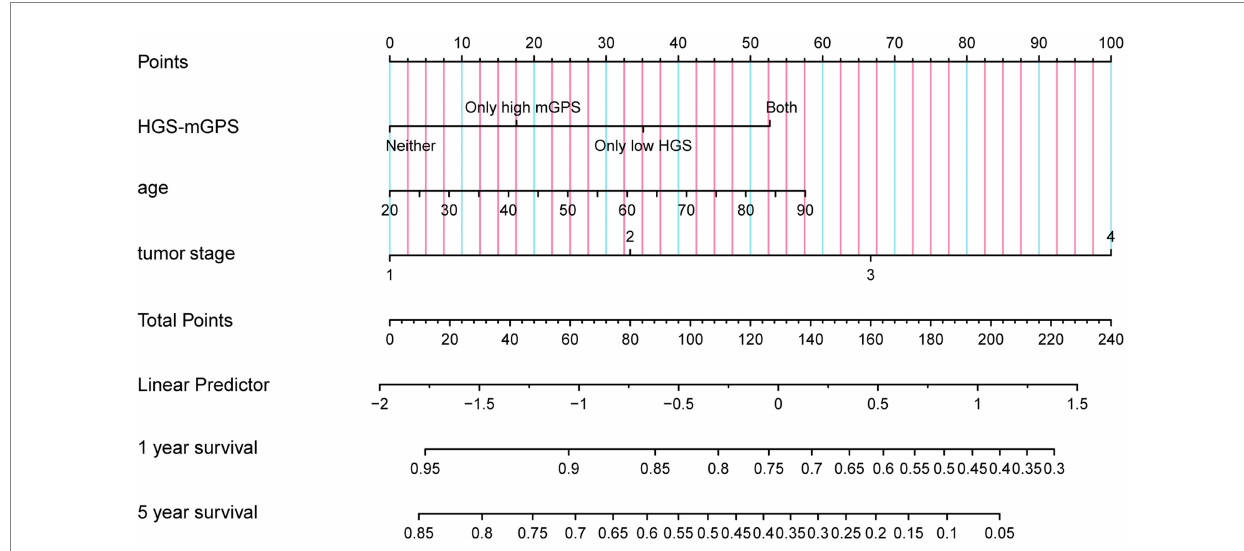
TABLE 4 Sensitive analysis (Excluded patients who died in 180 days) ( n = 413). N Model 0 Model 1 Model 2 HR (95%CI) p -value HR (95%CI) p -value HR (95%CI) p -value